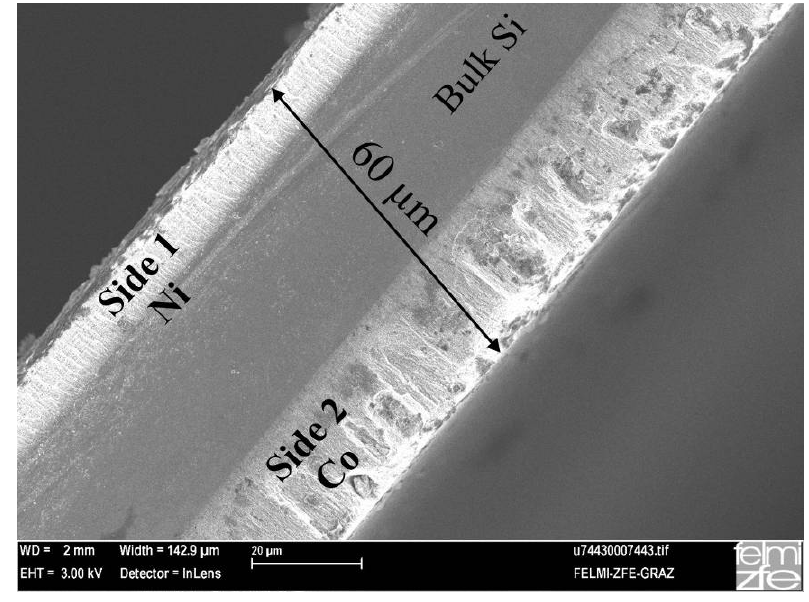
Figure 25. Ultrathin wafer with a thickness of 60 µm etched on both sides and filled with Ni on one side and Co on the other one. The thickness of the porous layer of side one is about 13 µm and of side two about 22